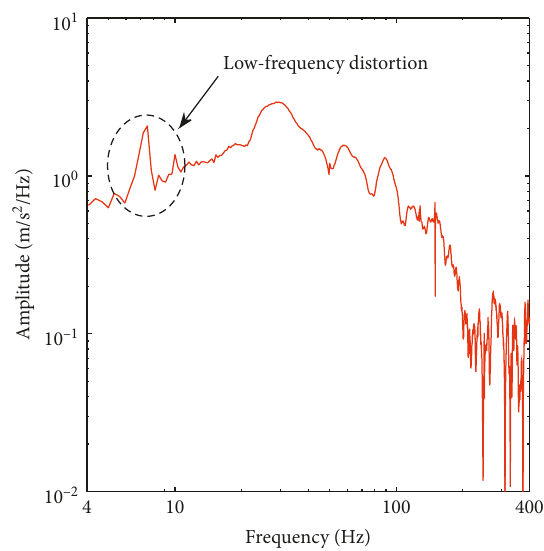
Figure 6: The FAS of the original shock acceleration signal.